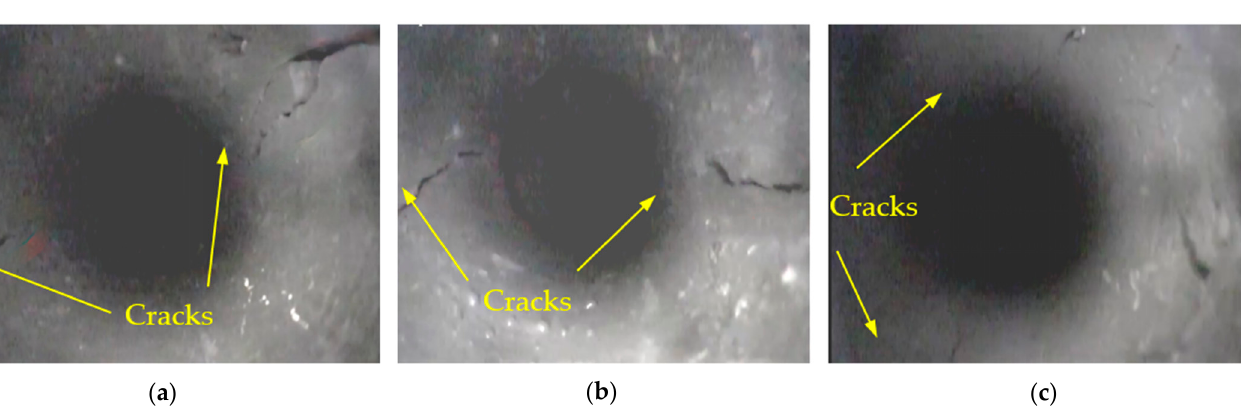
Figure 10. Blast hole drilling peep with different spacing. ( a ) Spacing 500 mm ( b ) Spacing 600 mm ( c ) Spacing 700 mm. ( c ) Spacing 700